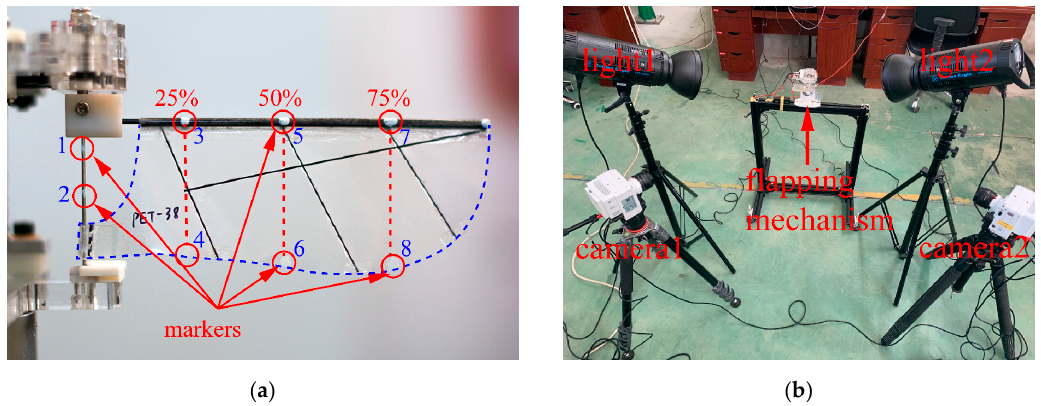
Figure 5. Deformation measurement setup. ( a ) Markers on the wing; ( b ) The experimental layout for the deformation measurement.